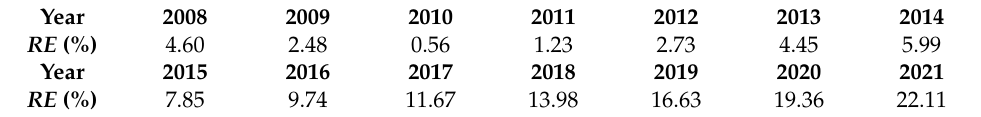
Figure 4. Dependency ratio versus time for the 2008–2021 period ( left ), and life expectancy at birth versus time for the 2008–2019 period ( right ), in Spain. Experimental values (dots) and theoretical values (line). Table 2. Relative errors in percentage (RE) for the dependency ratio in Spain in the 2008–2021 period.